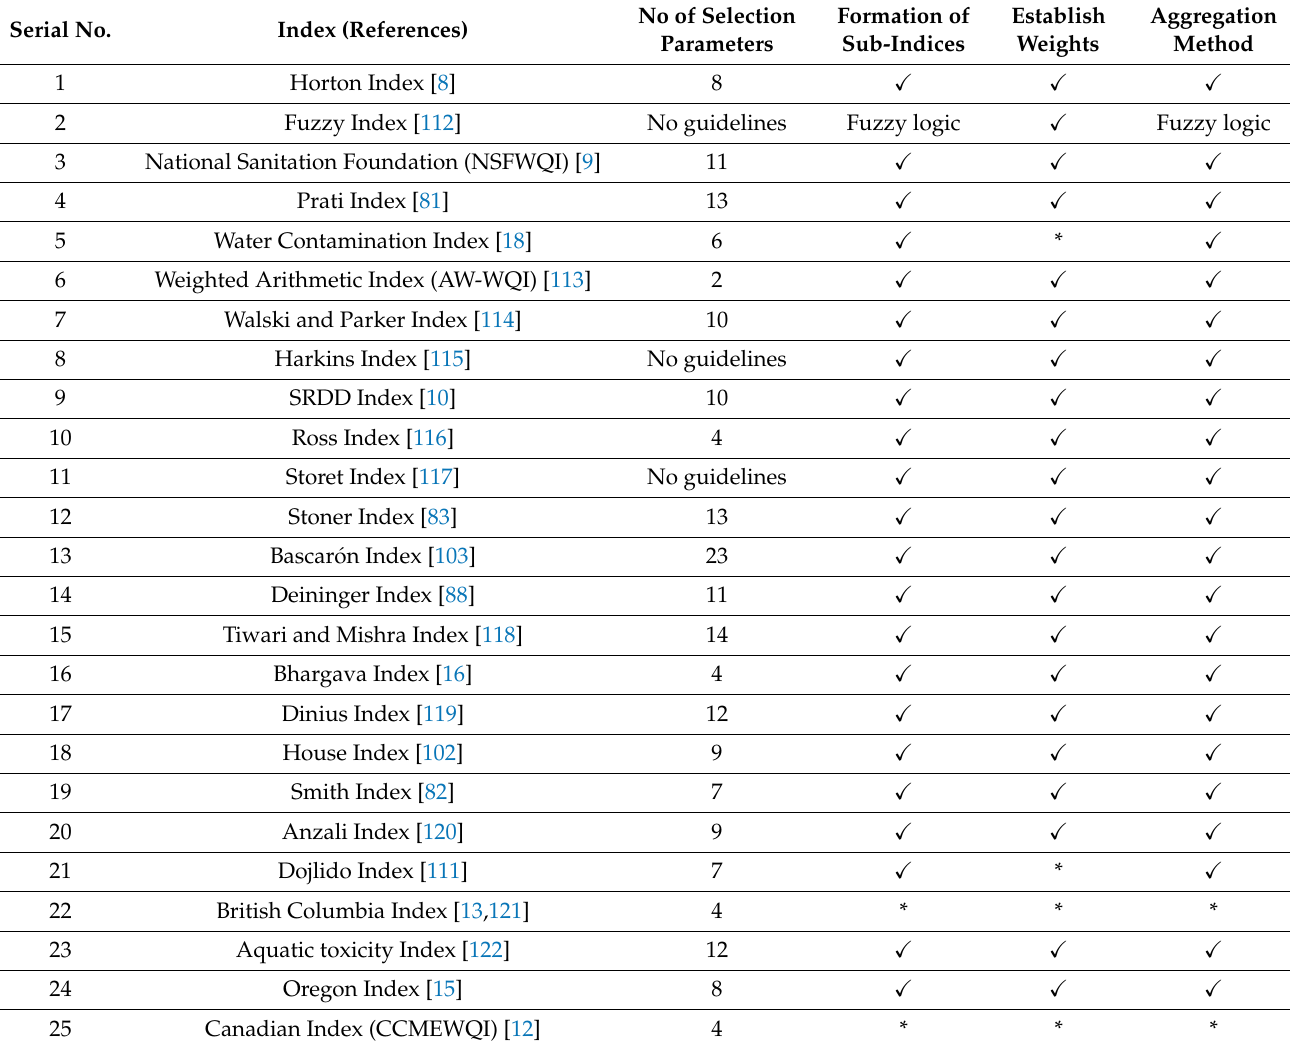
Table 3. This table addressed 46 WQI methods, from the 1960s to 2020. Several WQI developers used four steps, and several users applied a few steps. Serial